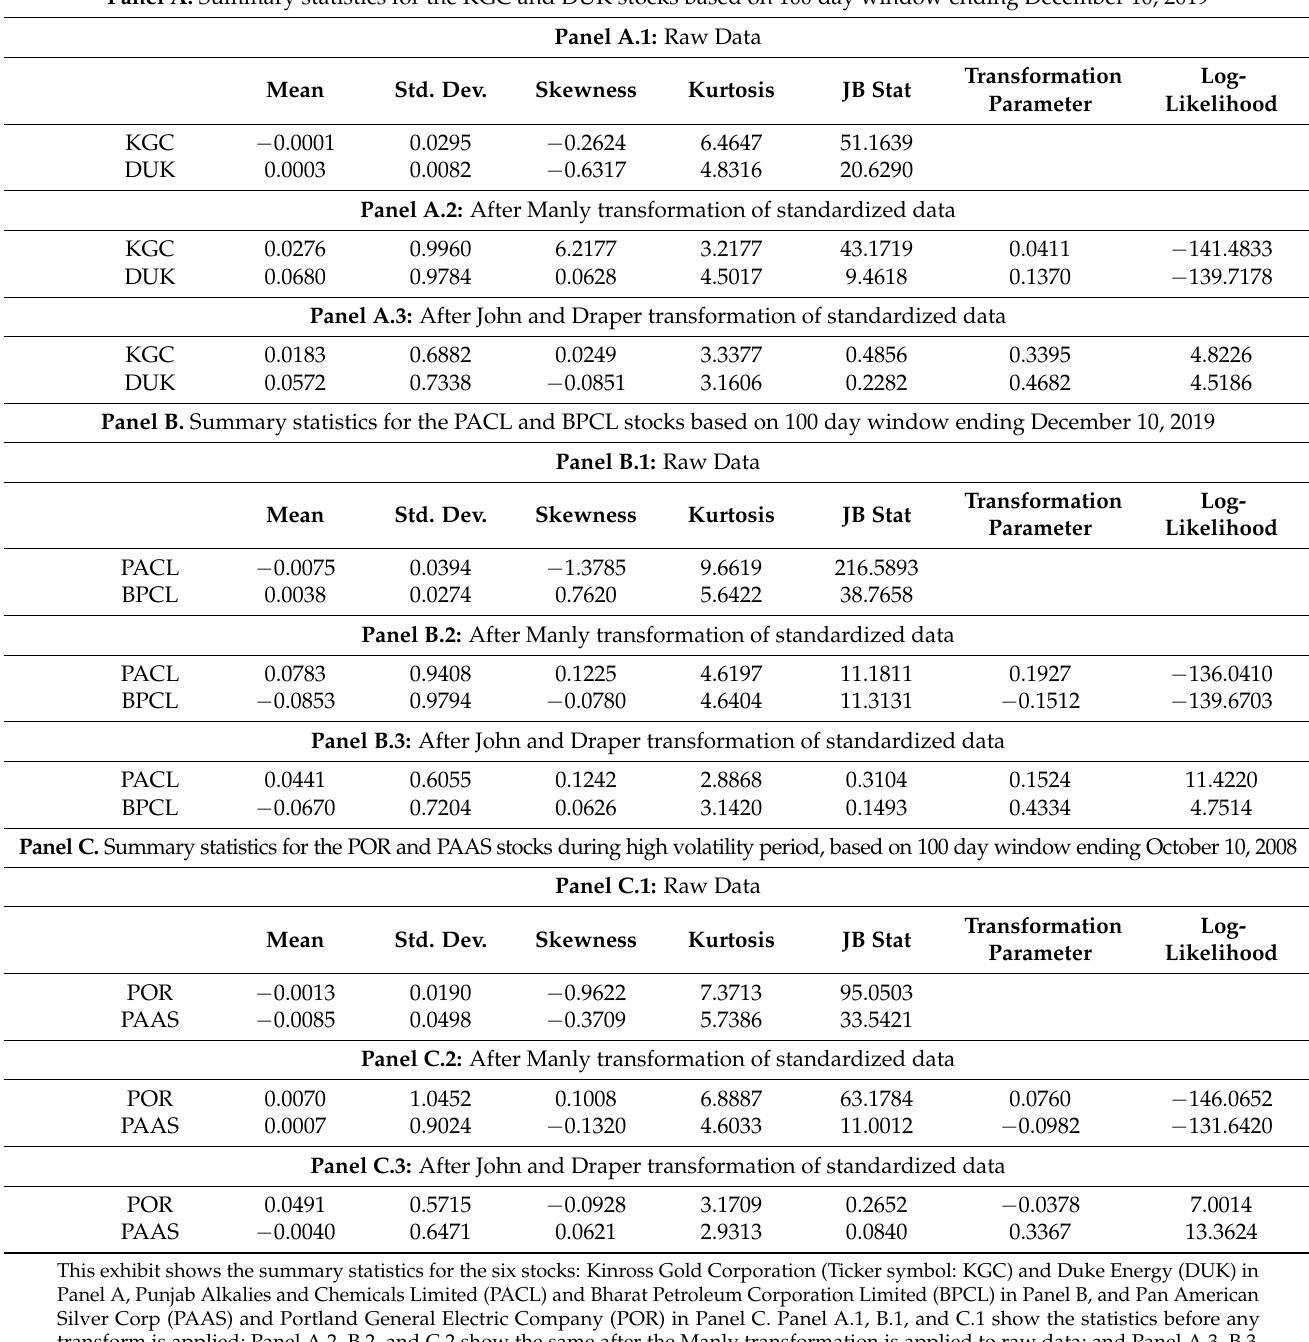
Table 2. Summary statistics for the three pairs of stocks chosen from different markets and different periods, using 100 day estimation window, before and after transforms.